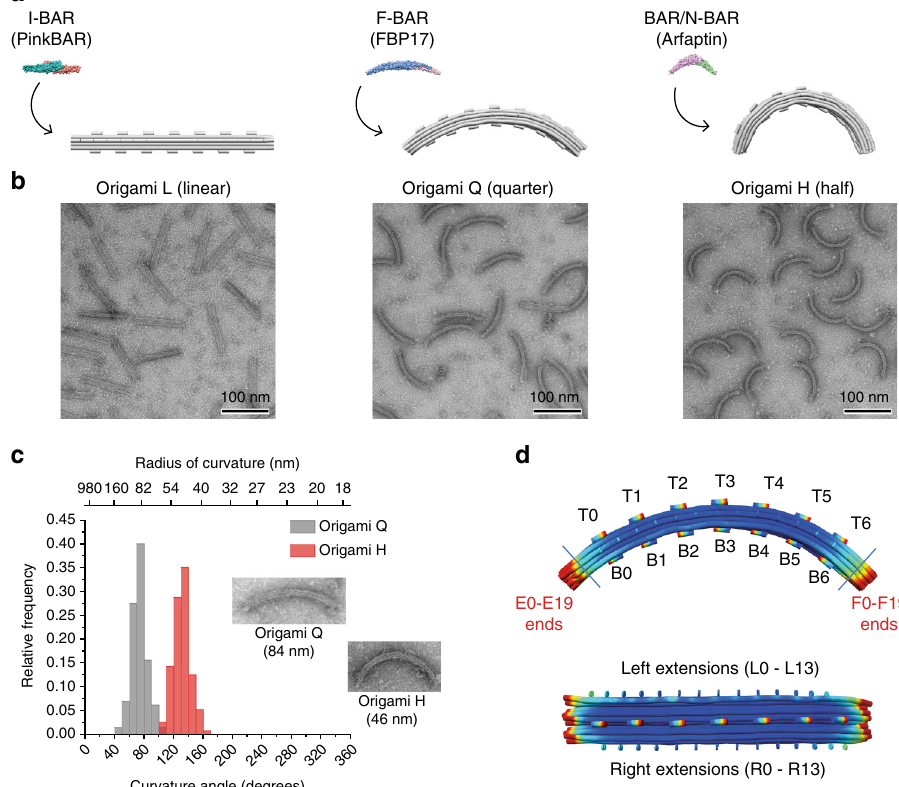
Fig. 1 BAR-mimicking DNA origami nanoscaffolds. a Structures of origami L (linear), Q (quarter) and H (half), which mimic the shape of I-BAR, F-BAR and BAR/N-BAR domains, respectively. b Corresponding negative-stain TEM images of the folded curved nanostructures. c The angle of curvature and respective radius of origami structures Q and H (84 and 46 nm, respectively) were experimentally determined from TEM images ( n = 110 – 130). d Schematic representation of marked positions on the top convex (T0 – T7), bottom concave (B0 – B7), lateral sides (L0 – L13, R0 – R13) and tips used on the nanoscaffolds (here origami Q) for attaching fl uorophores, membrane-anchoring moieties or oligomerizing staples. Scale bars: 100